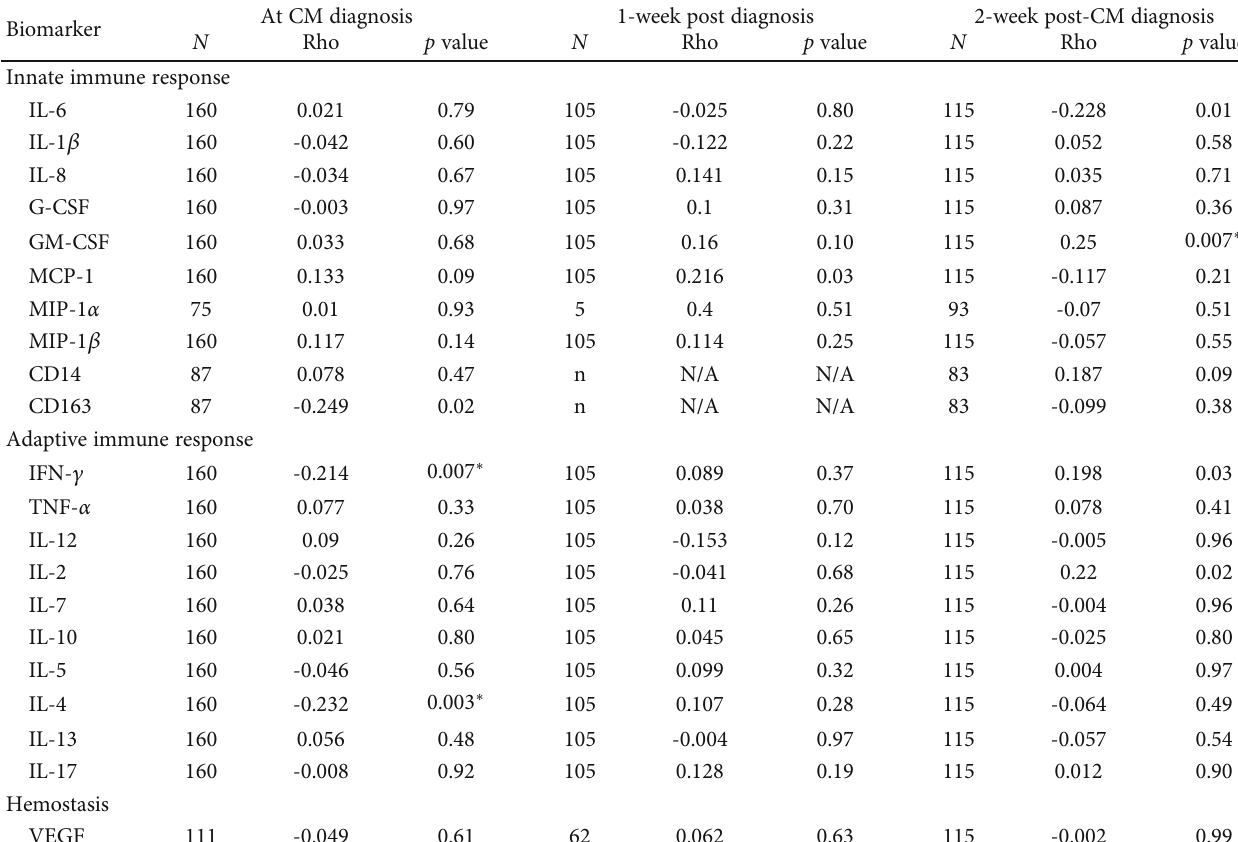
Table 1: Correlation of paired CSF and serum analytes at baseline, 1-week, and 2-week post cryptococcal meningitis diagnosis.